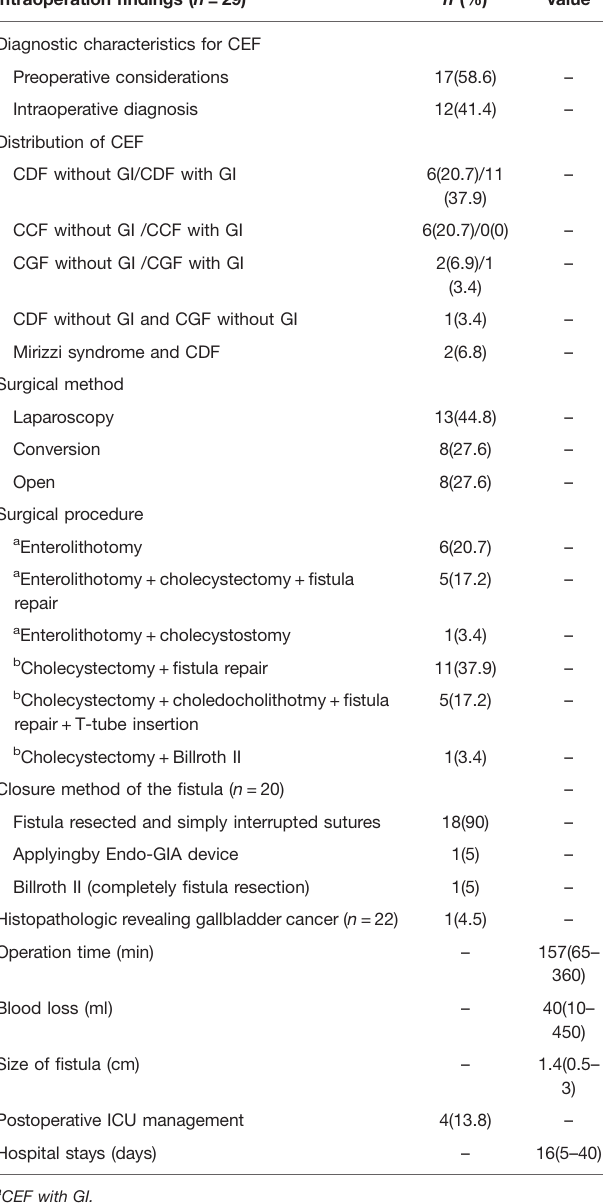
TABLE 2 | Appearance of medical examinations in all the patients enrolled in this